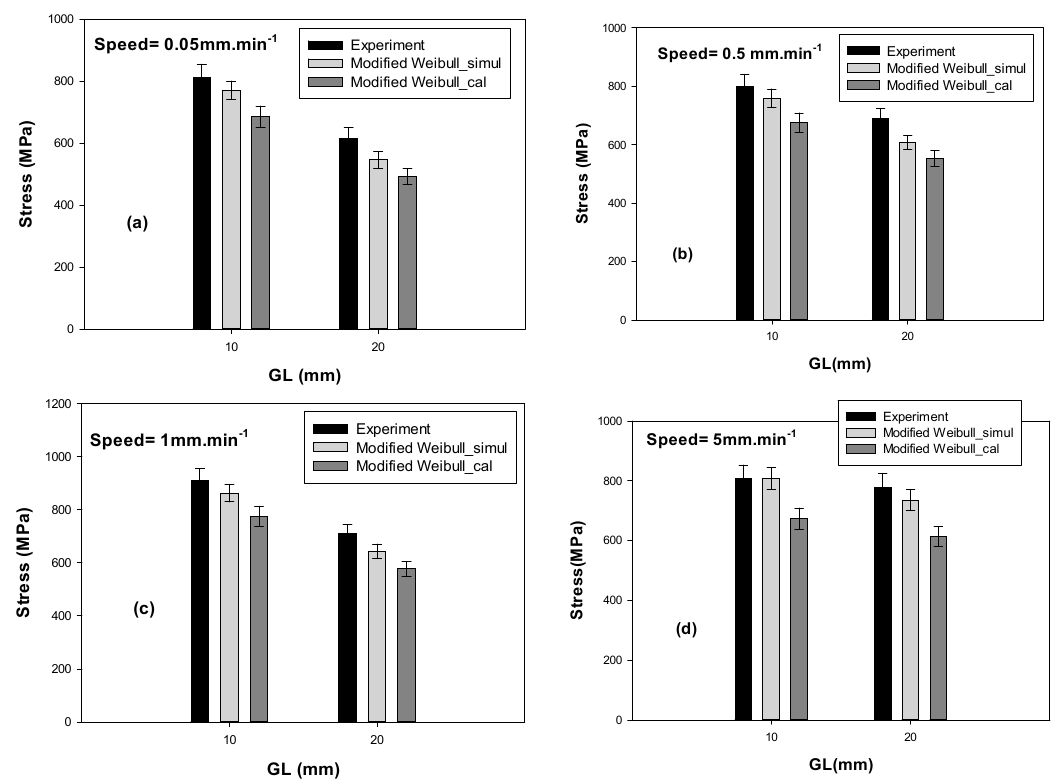
Figure 6 : Experimental versus predicted average strength diagrams. ( a ) Tensile strengths at 0.05